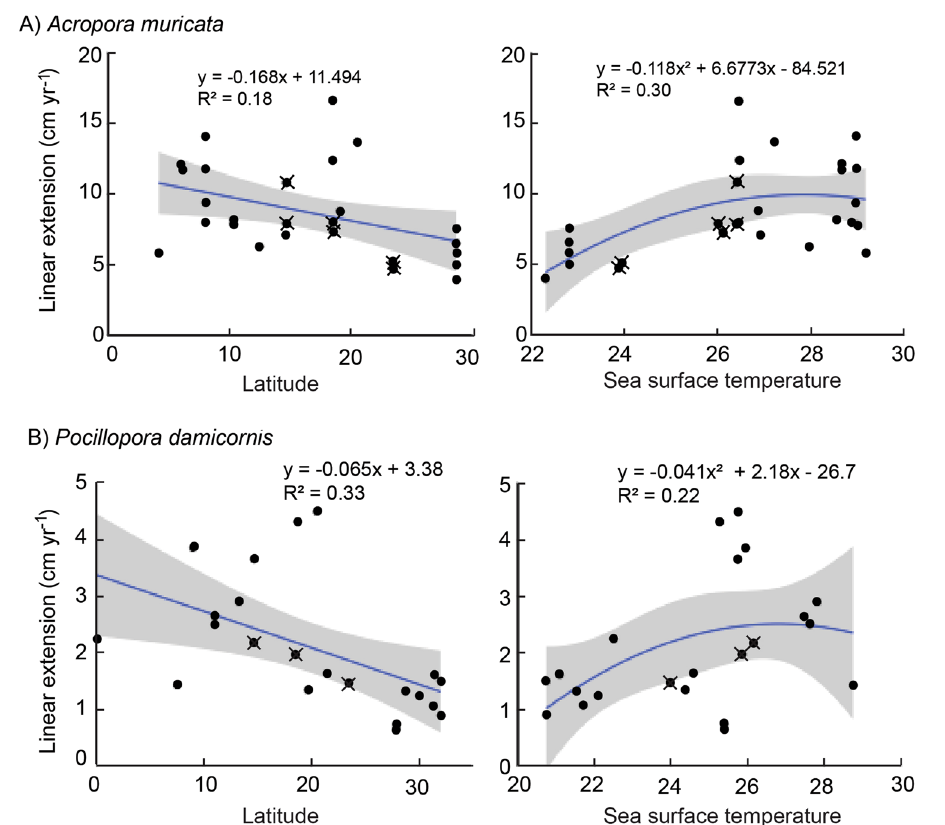
Figure 6. Variation in linear extension rates (cm yr − 1 ) of ( A ) A . muricata and ( B ) P . damicornis with latitude and sea surface temperature (°C). Data points arisen from this study are dots with crosses. Values for data points of A . muricata are in Supplementary Table S7 and P . damicornis in Supplementary Table S8. Shaded area represents 95% confidence